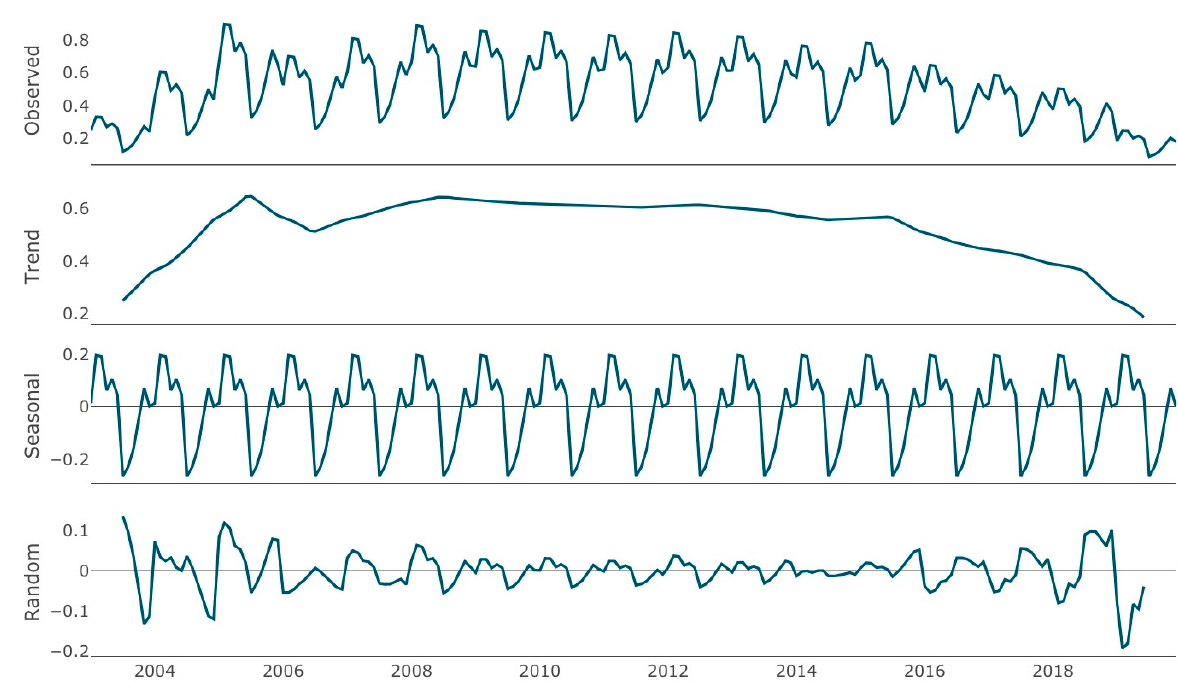
Figure 4. Decomposition of the monthly time series of the standardized Attention deficit hyperactivity disorder (ADHD) incidence rate by calendar year (both males and females).